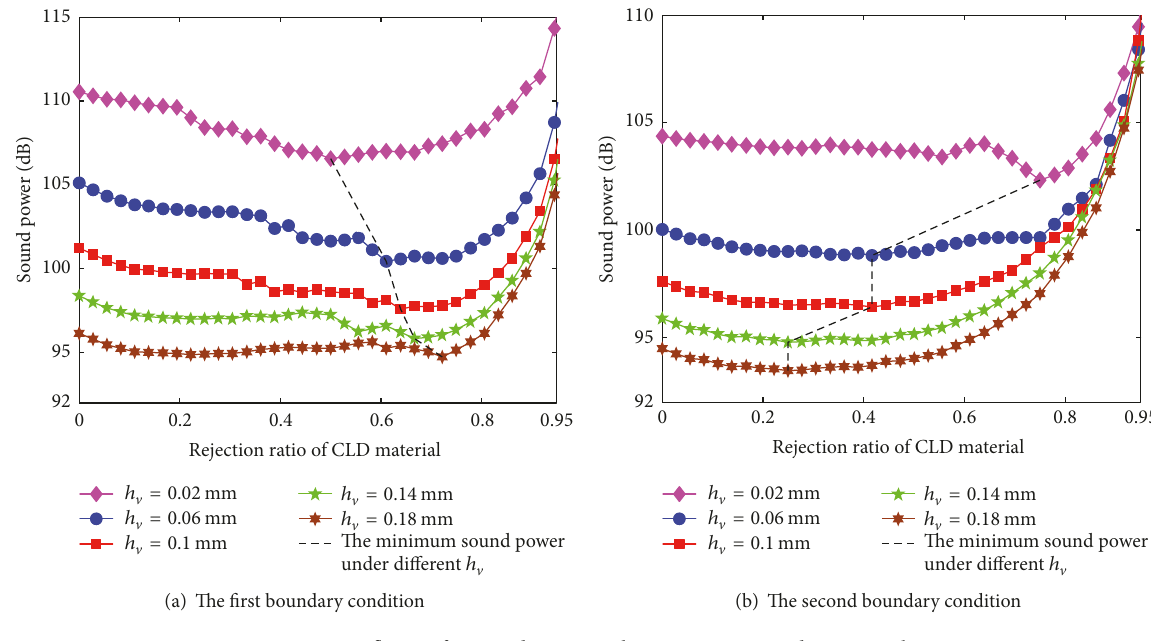
Figure 16: Influence for sound power with rejection ratio under various ℎ V .